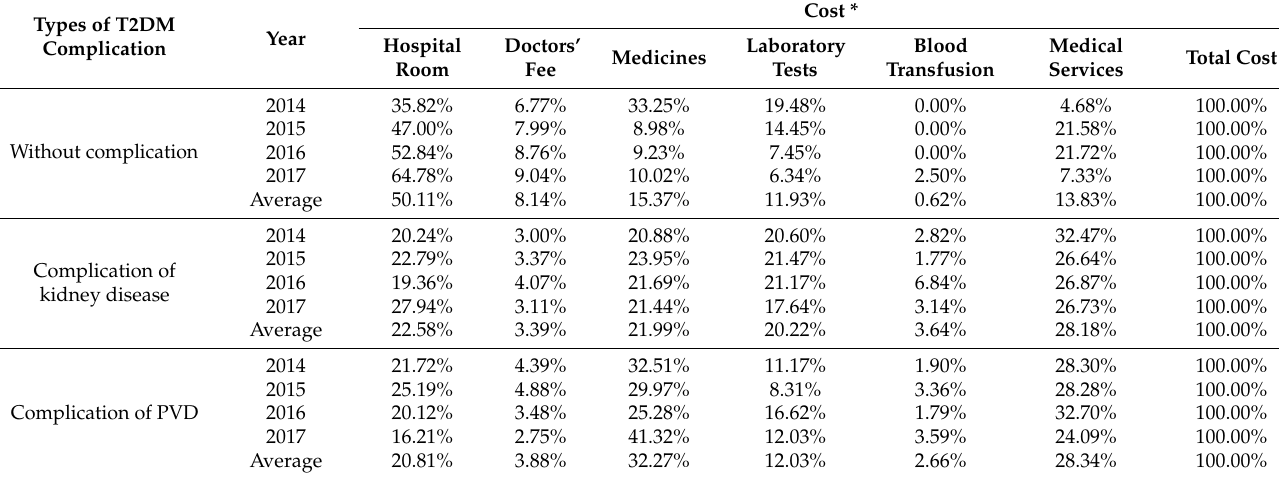
Table 3. Direct medical costs of T2DM treatment in